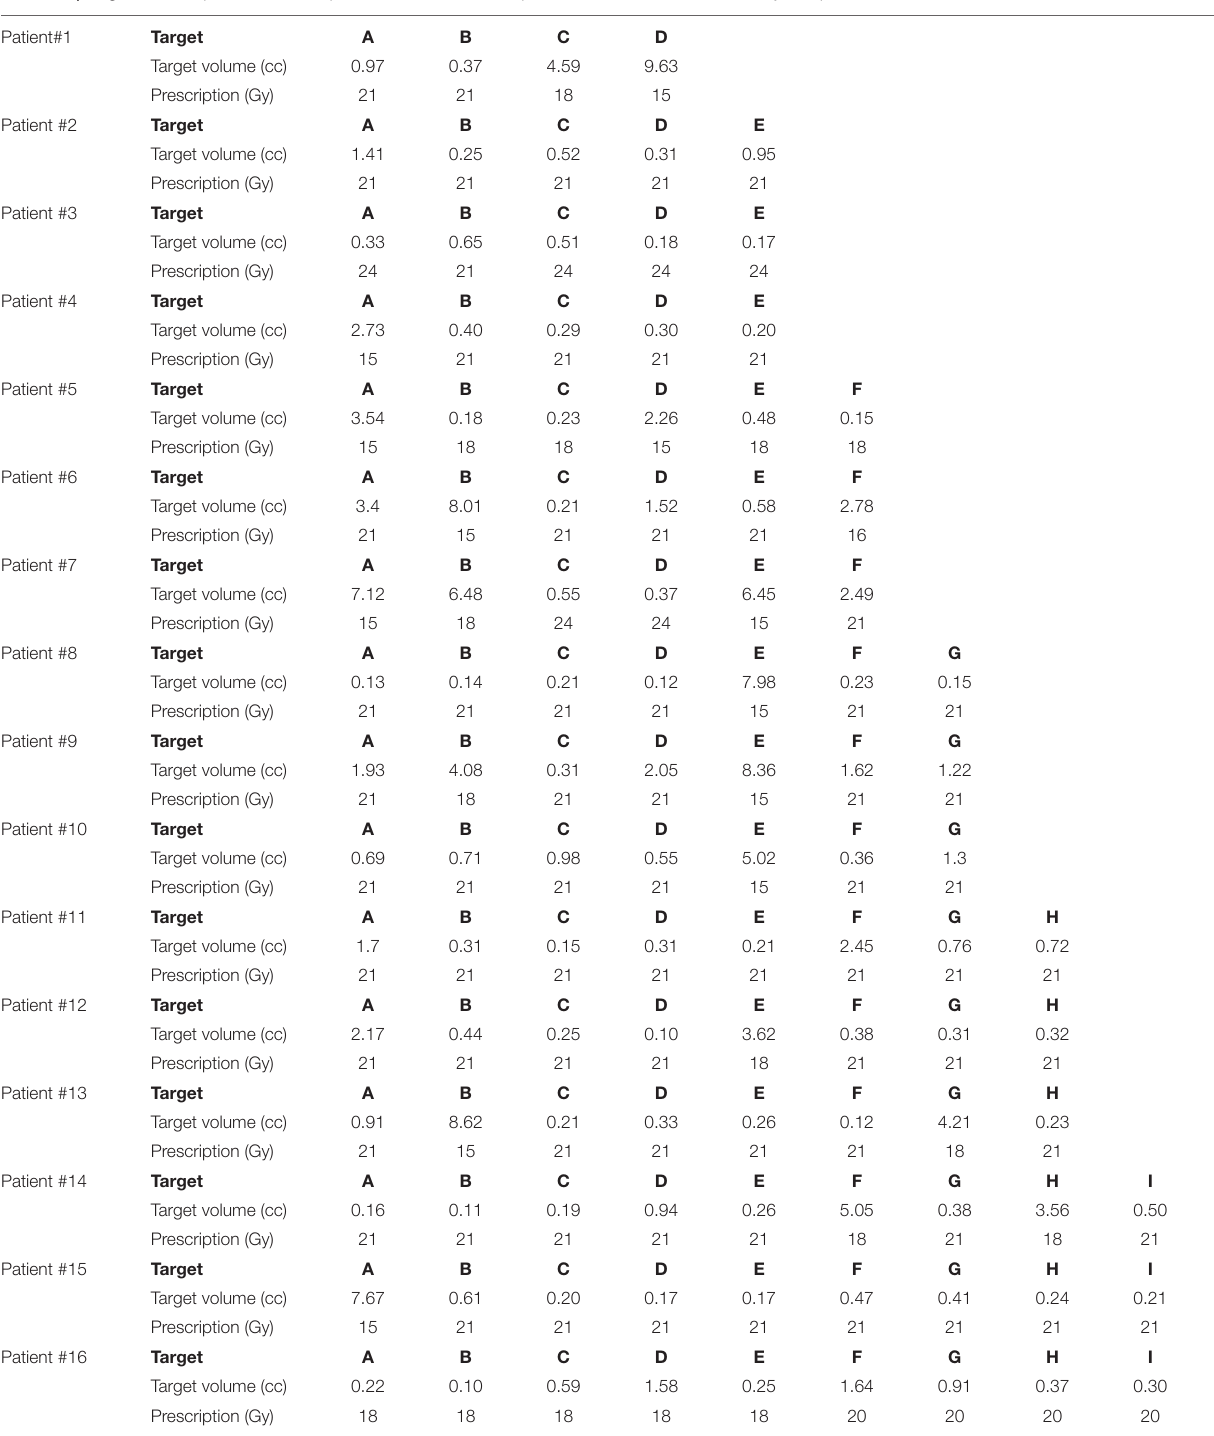
TABLE 1 | Target size and prescribed dose per metastasis for the 16 patients included in this SRS study comparison.